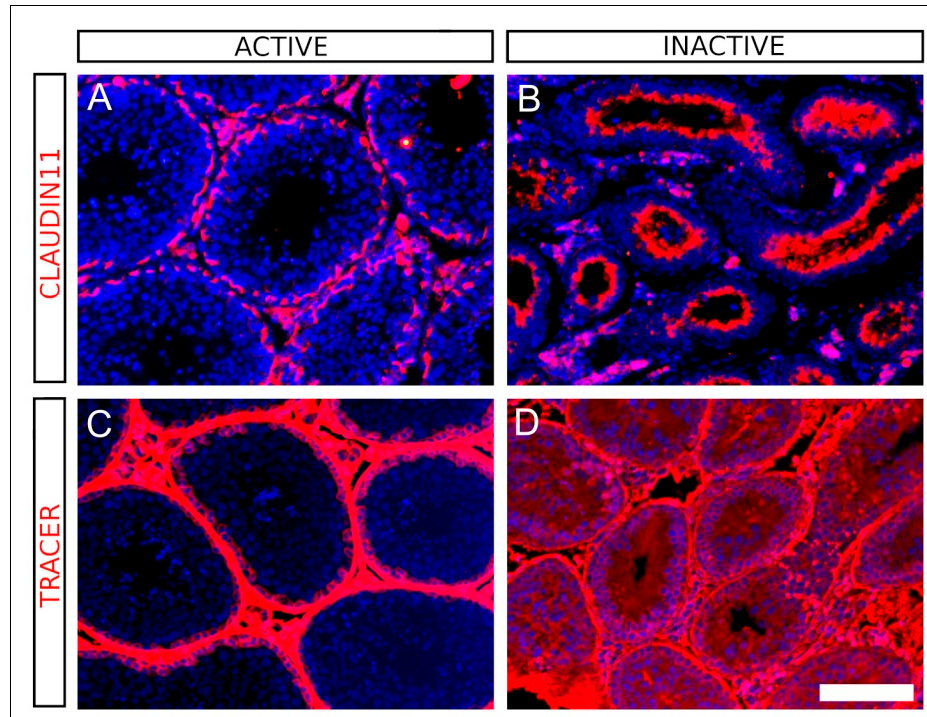
Figure 3. The BTB of regressed testes of M. duodecimcostatus is impaired. ( A , B ) Immunofluorescence for CLAUDIN11 in testes of voles captured in the wastelands. In winter ( A ), a sharp CLAUDIN11 immunoreactivity surrounding the seminiferous tubules just at the limit between the basal and the adluminal compartments can be neatly observed. In contrast, CLAUDIN11 expression pattern appears completely disorganized in the summer ( B ). ( C , D ) Test of BTB functionality using a biotin tracer (red fluorescence) of voles captured in the wastelands. In winter ( C ), the tracer did not penetrate beyond the basal compartment, whereas in summer immunoreactivity was detected in deepest areas of the regressing seminiferous tubules ( D ). Testis sections were counterstained with DAPI. Scale bar shown in ( D ) represents 100 μ m for all pictures.